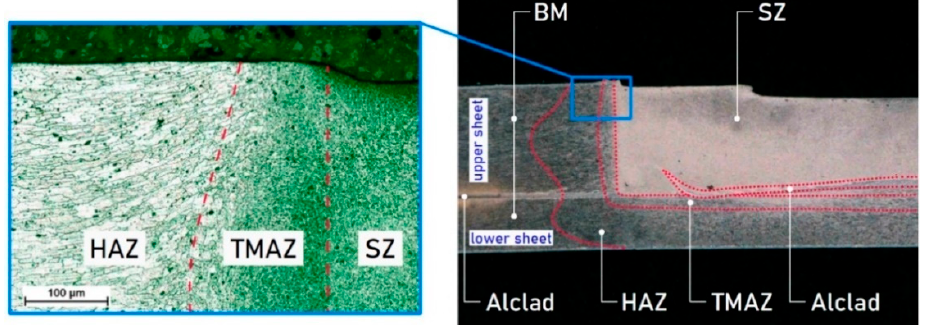
Figure 3. Critical zones of the FSSW joint (experiment